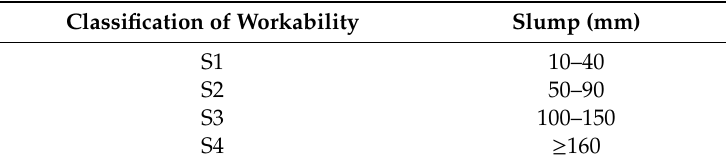
Table 5. Classification of Workability and Magnitude of Slump.